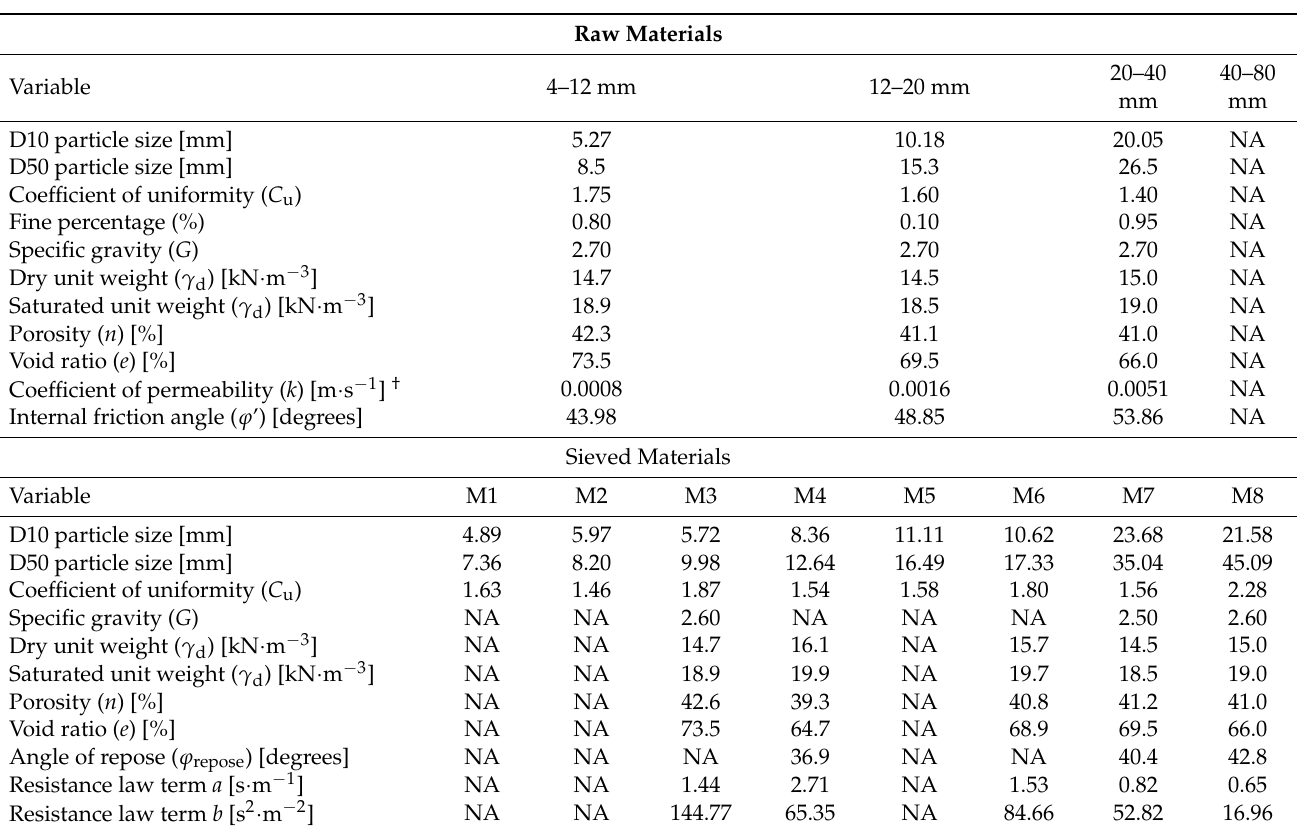
Table 2. Summary of the main geotechnical characteristics of the gravels used in the construction of the physical models. NA means ‘not available’.